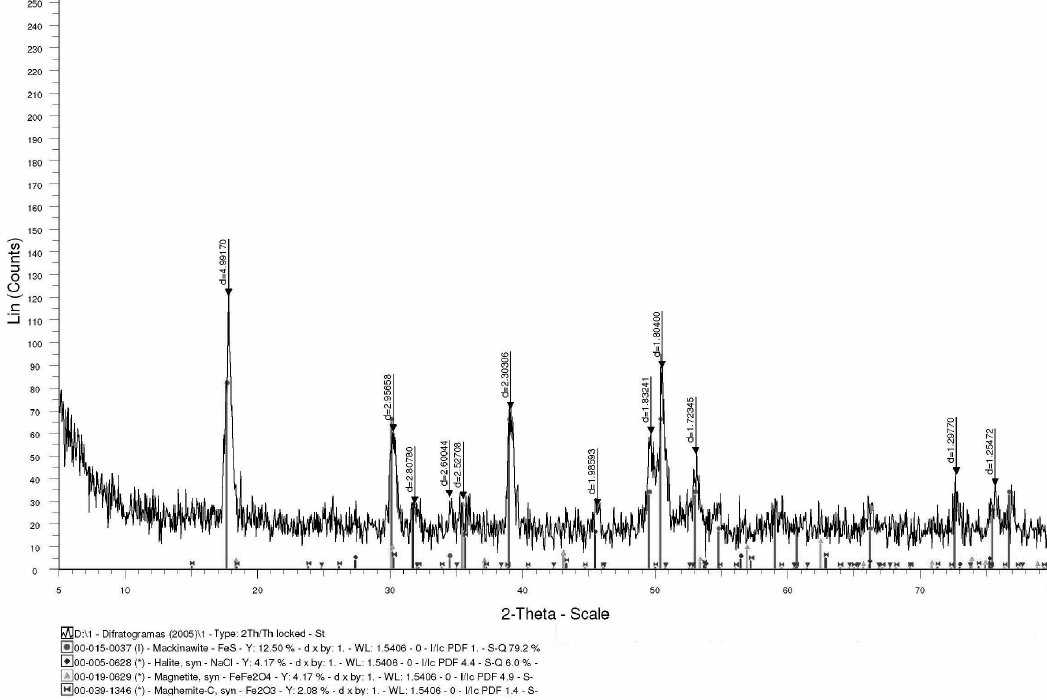
Figure 10. XRD spectrum of the corrosion product film of the welded joint tested in solution 1, pH=3.0.